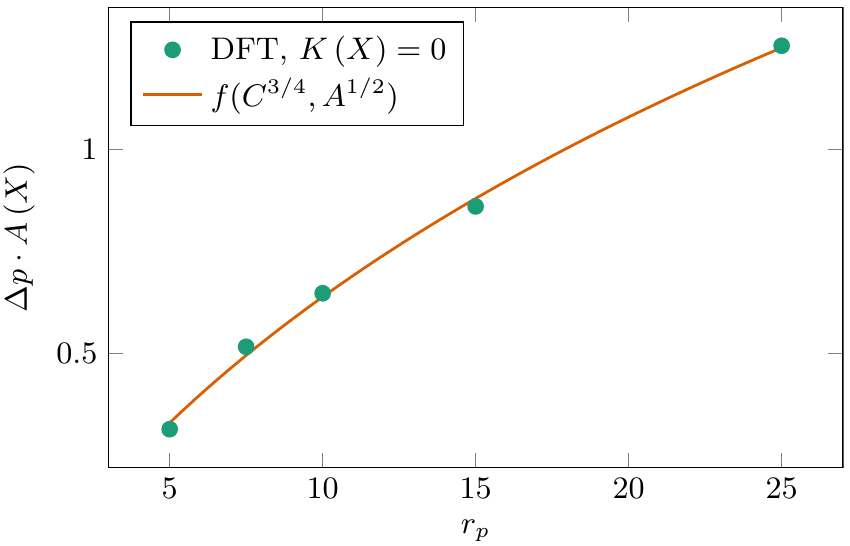
Figure 6. Dimensionless pressure difference between the capillary condensation pressure and bulk phase transition pressure times the surface area Minkowski functional, ∆ p · A ( X ) , as a function of pore radius, r p . The Minkowski functional for topology is zero in all the shown simulations, K ( X ) = 0. The curve fit is equal to: f ( C 3/4 , A 1/2 ) = Ω lg + σ (cid:48) C ( X ) and A ( X ) only depend on r p . The coefficients are Ω lg = − 0.4 ± 0.2, σ (cid:48) = − 0.04 ± 0.02. In dimensional form, from left to right the pressure differences are 97 kPa, 69 kPa, p (cid:48) lg 49 kPa, 29 kPa, and 15